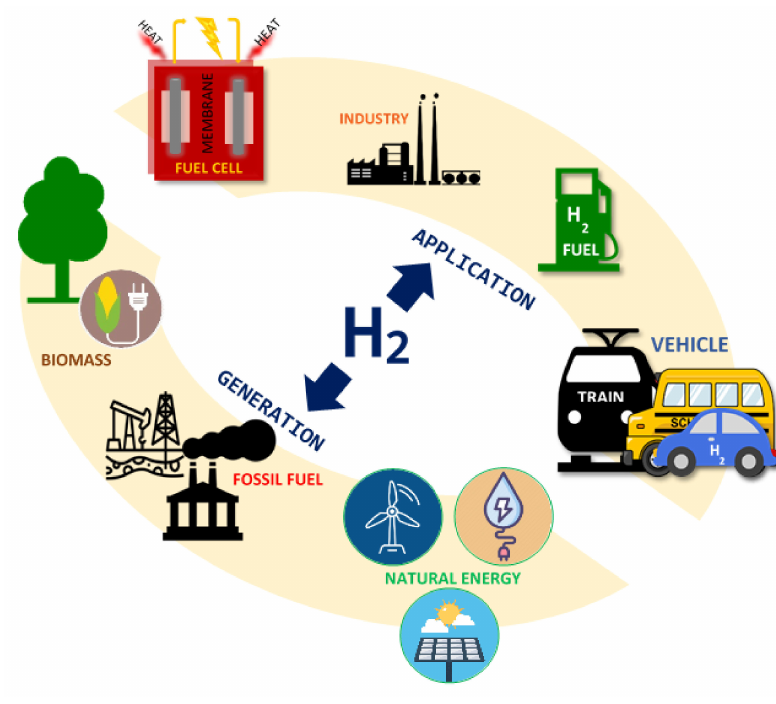
Figure 1. Hydrogen as an energy